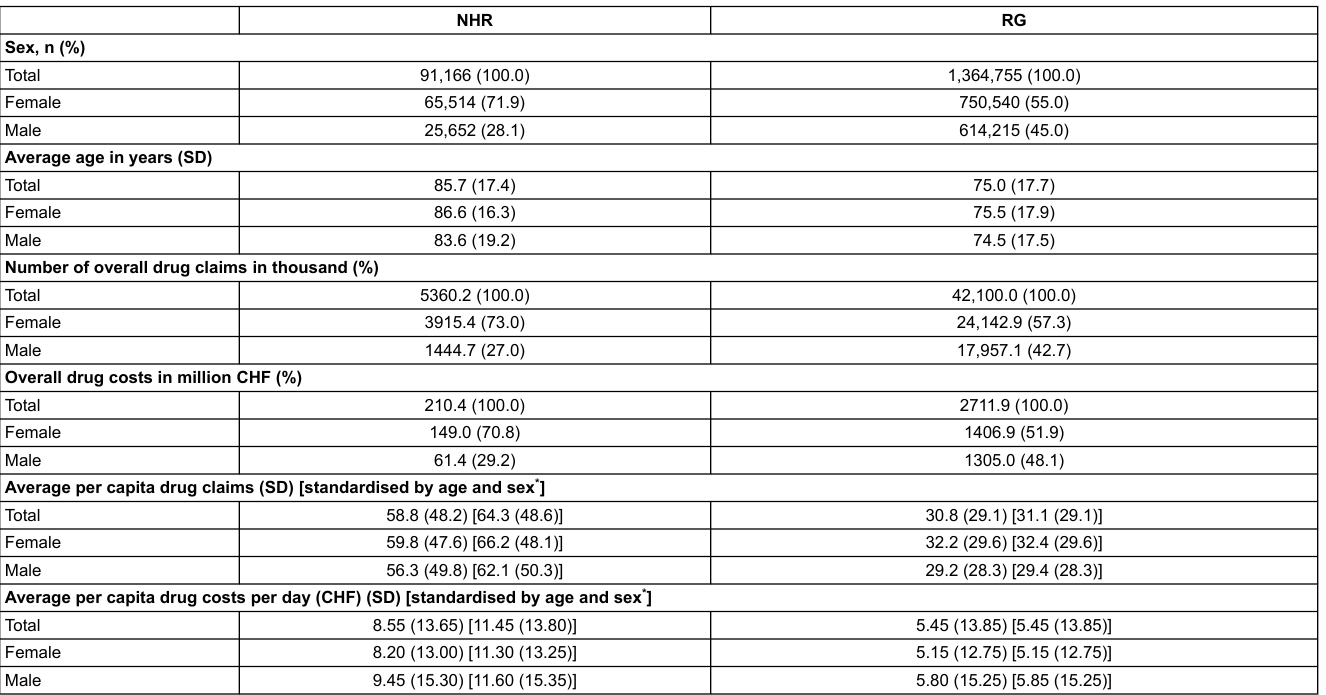
Table 1: Characteristics of Swiss NHR and the RG (individuals aged ≥65 years insured with Helsana, excluding NHR) including drug claims and drug costs, year